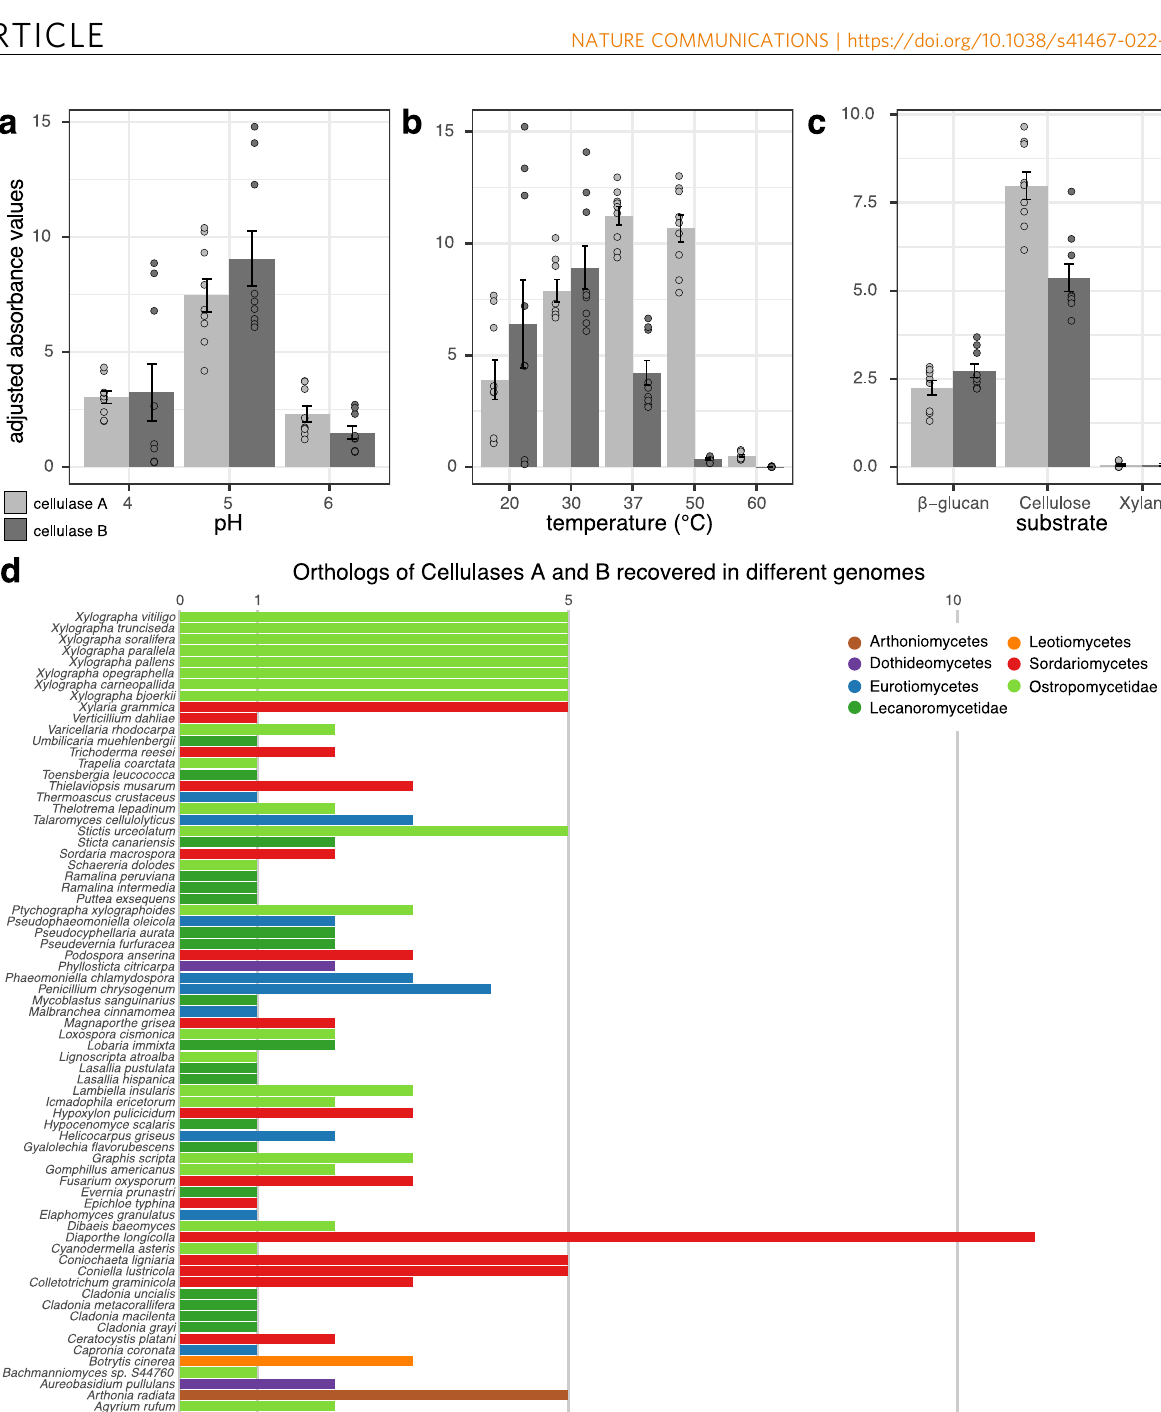
Fig. 4 Enzymatic activity of two putative cellulases A and B from Xylographa bjoerkii and orthologs of these genes. Activity of cellulases A and B at different pH conditions ( a ), at different temperatures ( b ), and with different substrates ( c ). Y axis represents mean absorbance ( + / − standard error of mean) at 595 nm after adjusting for the dilution factor. Experiments were performed in technical and biological triplicates. d Number of orthologs of cellulase A and B in the 72 genomes that possess them. Different colors indicate taxonomic groups; genomes from the subclasses Acarosporomycetidae and Umbilicariomycetidae use the same color codes as Lecanoromycetidae for simplicity. Source data are provided as a Source Data fi